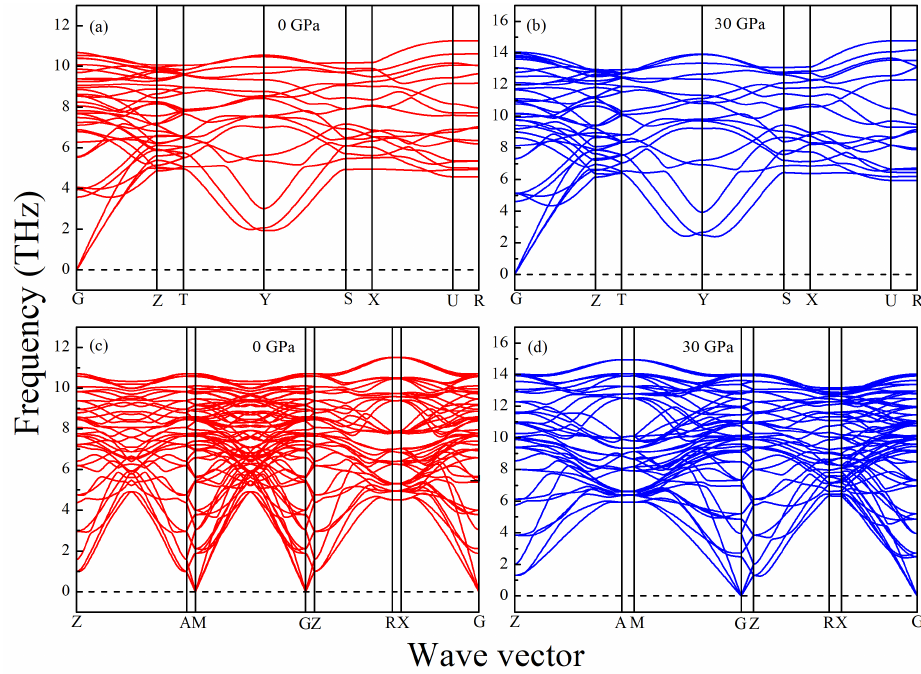
Figure 4. Phonon spectra of the LPSs ( a , b ) h-Al 2 Ti and ( c , d ) r-Al 2 Ti under 0 and 30 GPa at 0